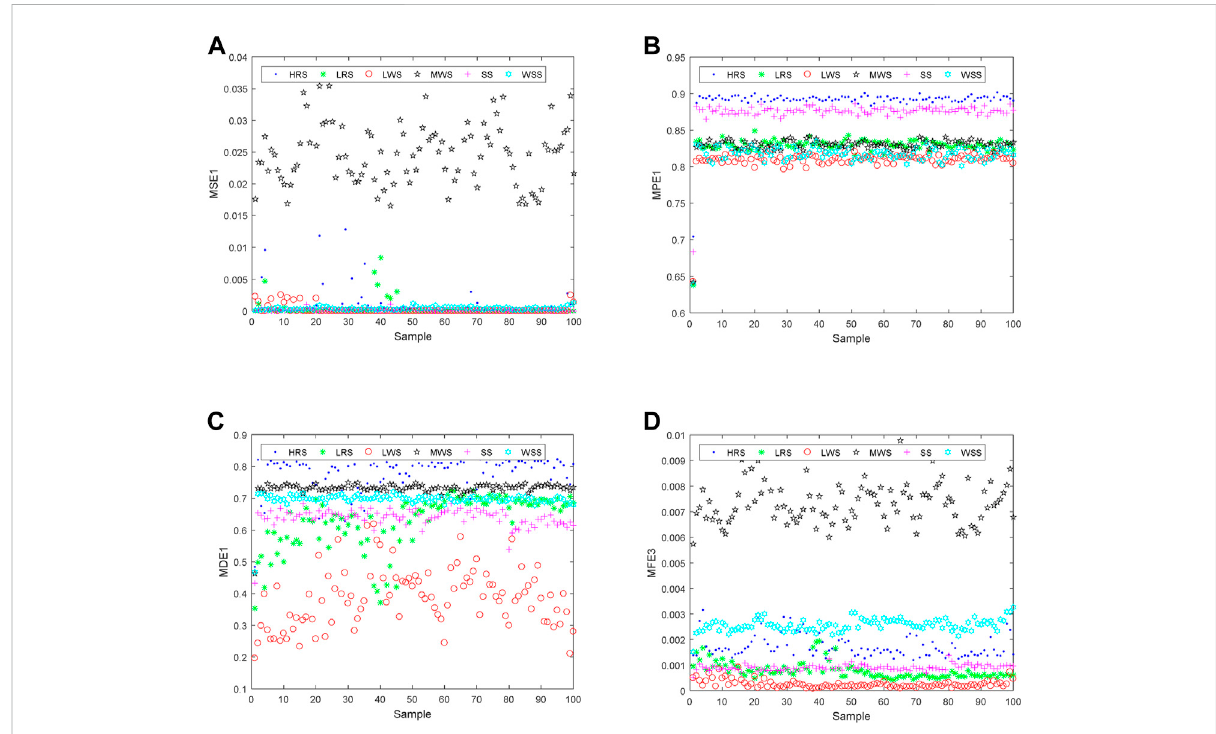
FIGURE 4 Single-feature distribution correspond to the highest ARR for six ANs. (A) is MSE, (B) is MPE, (C) is MDE, (D) is MFE.